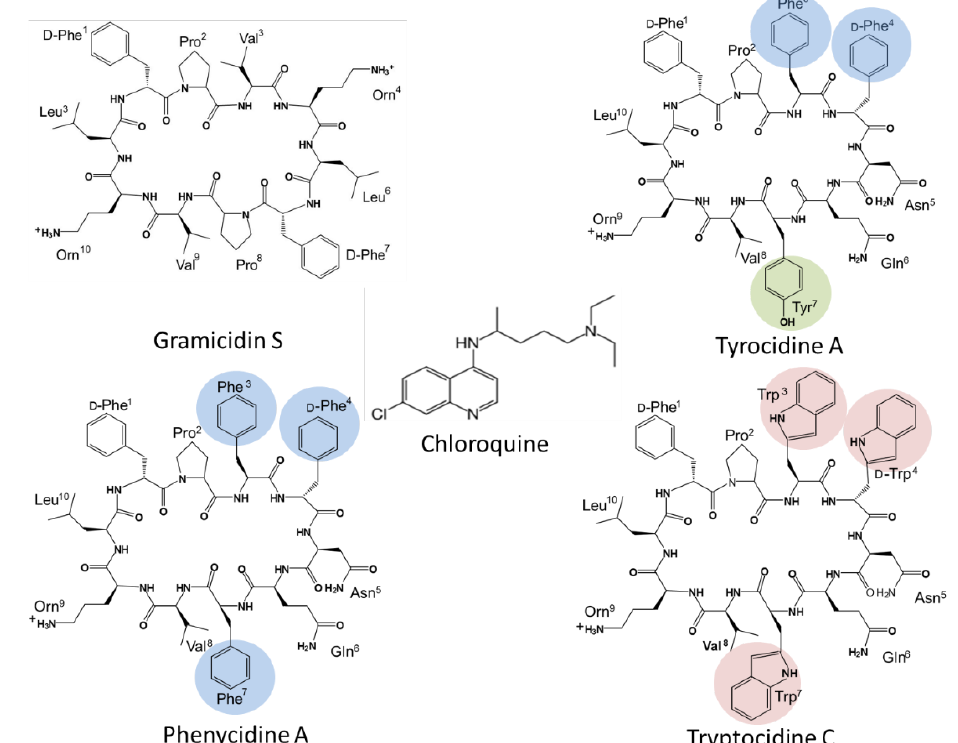
Figure 1. The chemical structures of gramicidin S (GS), tyrocidine A (TrcA), phenycidine A (PhcA), tryptocidine C (TpcC), and chloroquine (CQ).